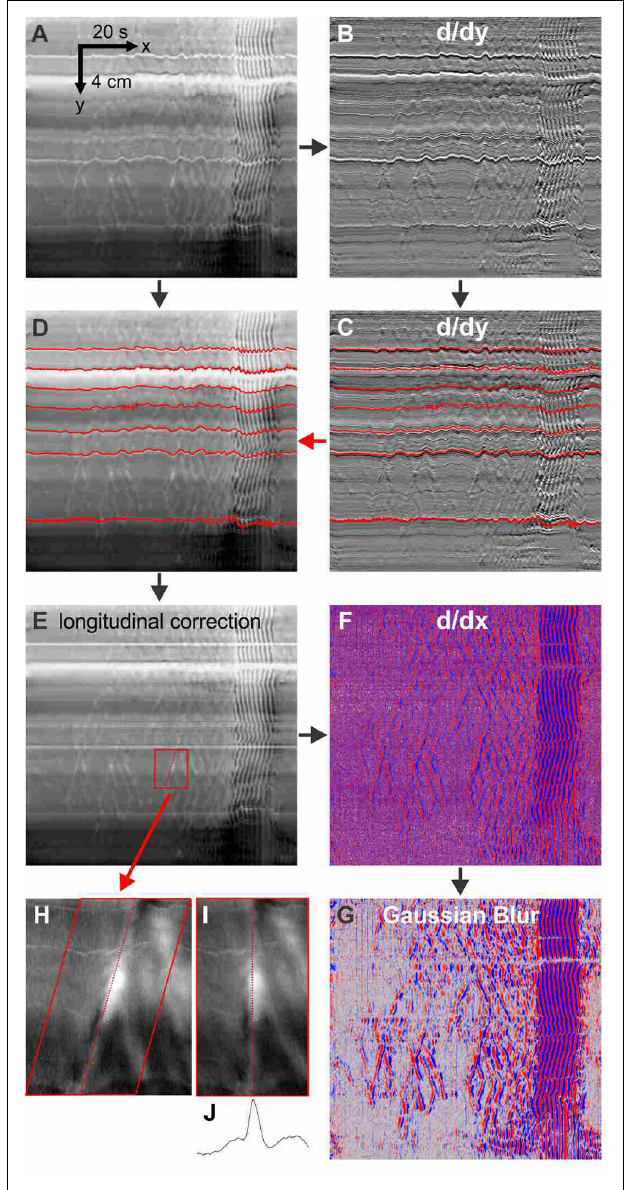
FIGURE 1 | Methodology. The processing of DMaps to highlight relaxation waves. Horizontal stripes in the DMap (A) , resulting from tonic differences in intestine diameter such as Peyer’s patches and uncut mesentery, are accentuated by differentiation along the spatial/y axis (B) . The wiggling up and down of the stripes represents longitudinal movement of the intestine. The stripes are tracked by a least-difference algorithm ( C , red lines ) and applied to the original DMap (D) to correct for longitudinal movement (E) by equalizing over time the distance between any two stripes. The longitudinal-corrected DMap is differentiated along its time/ x axis (F) - reds are positive derivatives (relaxation) and blue are negative derivatives (contraction). This is convolved with a 4 pixel-width Gaussian blur filter (G) . A region from the longitudinal-corrected DMap (H) is shear transformed so that the axis of the relaxation wave is realigned vertically (I) . The spatial average of the realigned image (J) gives a diameter profile of the wave. For differentiation we used the FeatureJ plugin package of ImageJ. The Gaussian blur is a standard routine in ImageJ. Stripe tracking, longitudinal correction and wave realignment were custom ImageJ